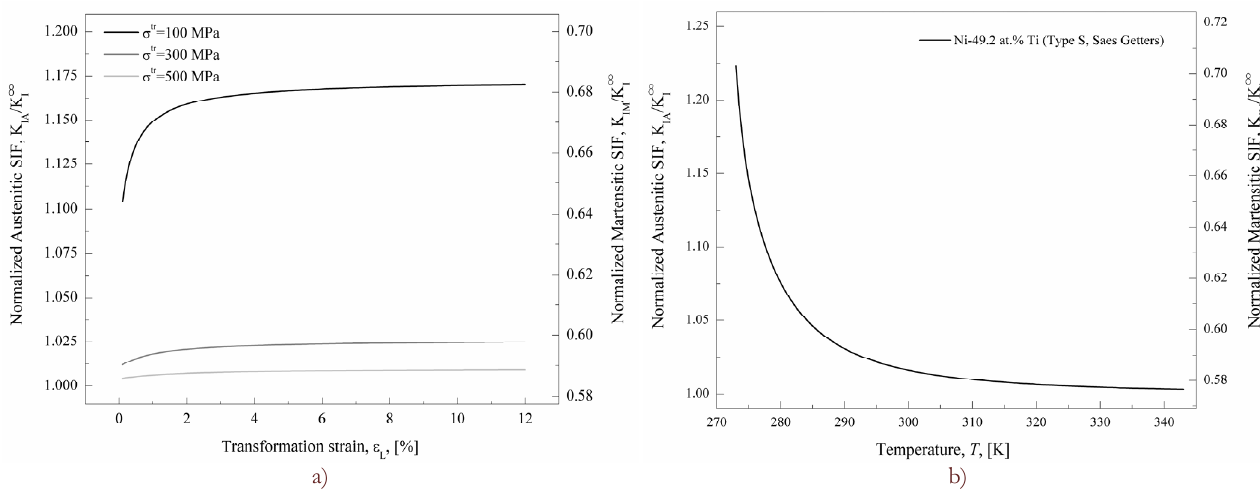
K and K , normalized with respect to the applied SIF, Figure 6: Martensitic and austenitic SIFs, IA IM  ) and for different values of the transformation stress ( tAM r   ), b) the testing temperature ( T ) transformation strain  ( L